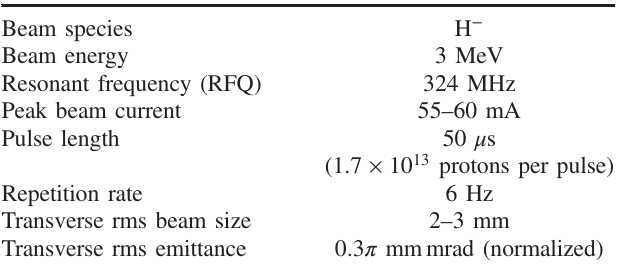
TABLE I. The typical parameters of J-PARC medium energy beam transport (MEBT) line test stand.